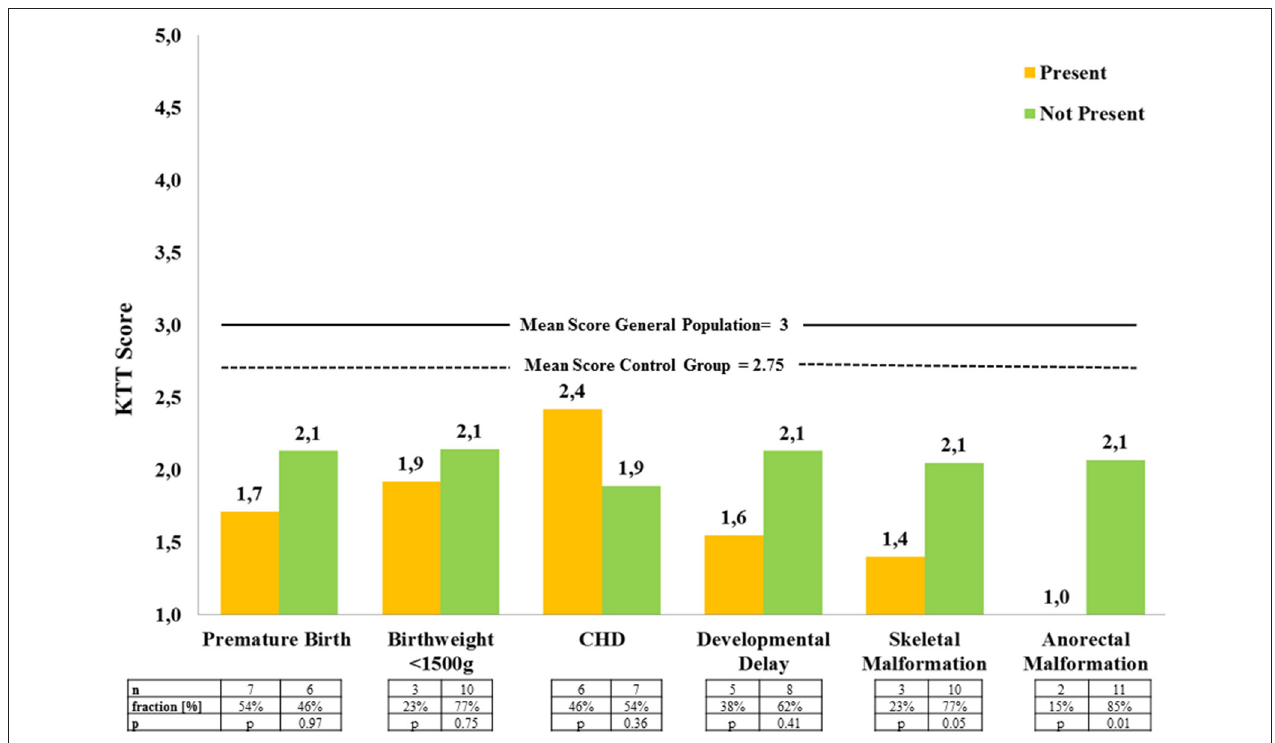
FIGURE 3 | Mean locomotor test results of EA patients with and without associated comorbidity ( KTT = Kinderturntest Plus , CHD = congenital heart disease).